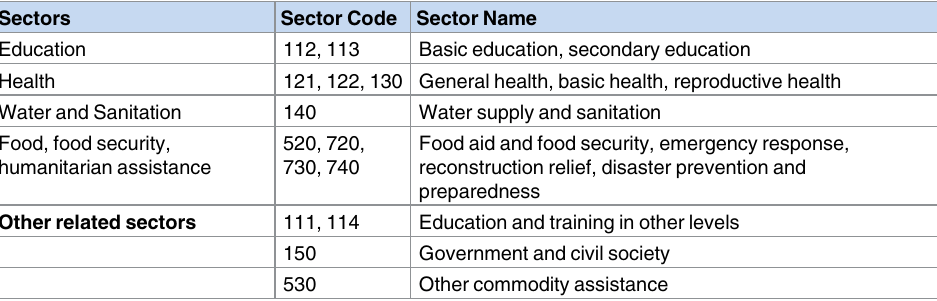
Table 1. Sectors on determining child survival in the CRS